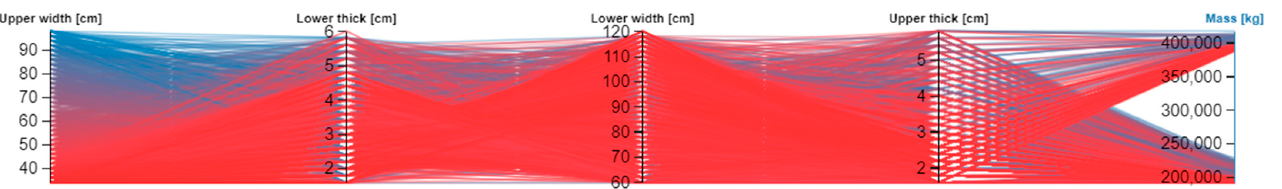
Figure 16. Optimization results plot using Design Explorer 2© .